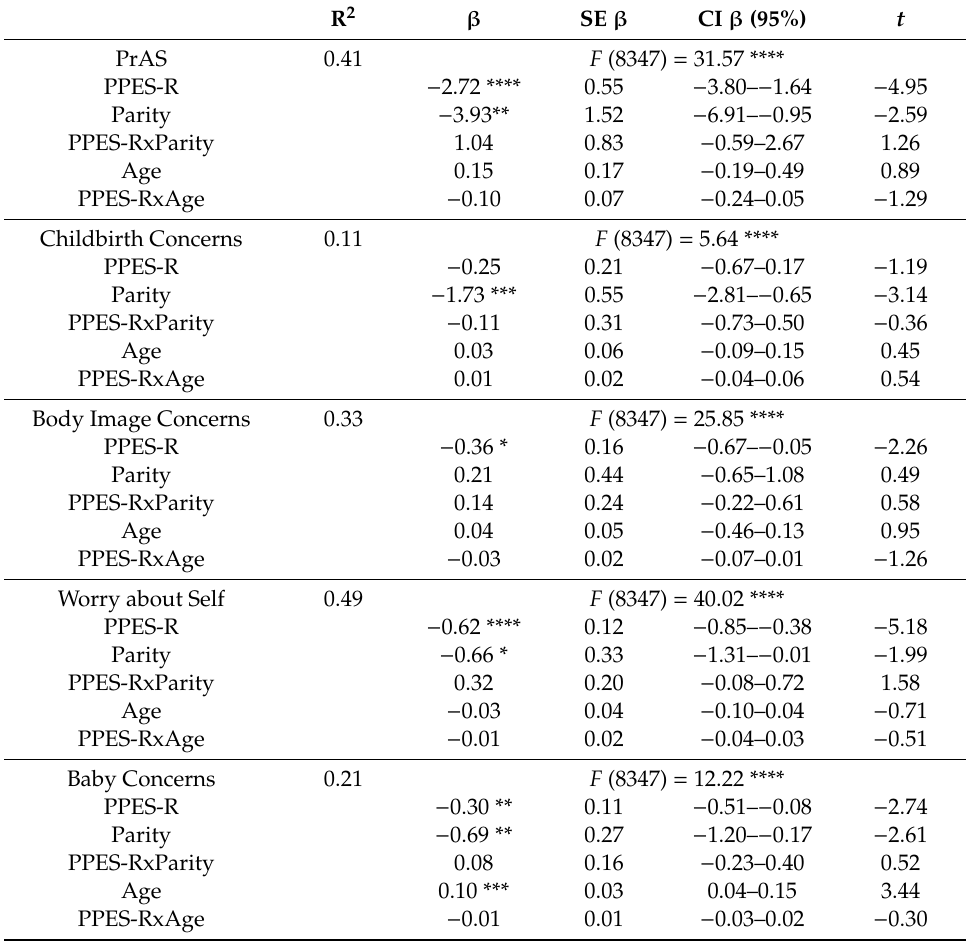
Table 7. Total and indirect e ff ect of perceived parental self-e ffi cacy on pregnancy-related anxiety. R 2 β SE β CI β